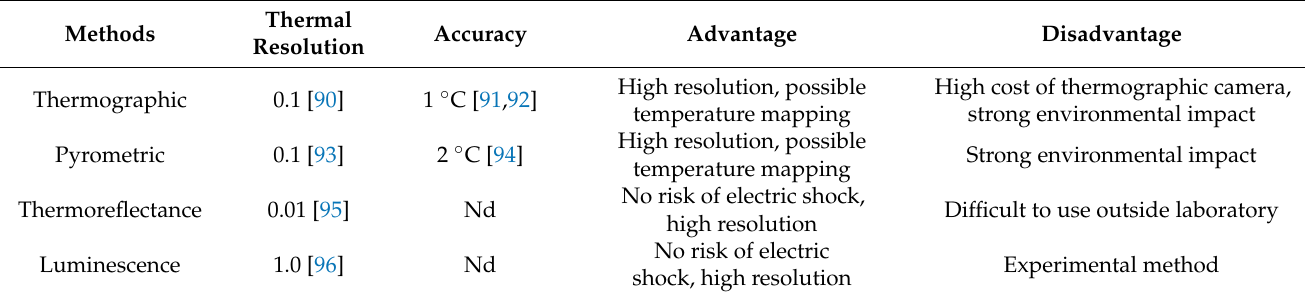
Table 2. Summarized thermal resolutions, advantages and disadvantages of all described non-contact methods to measure semiconductor die